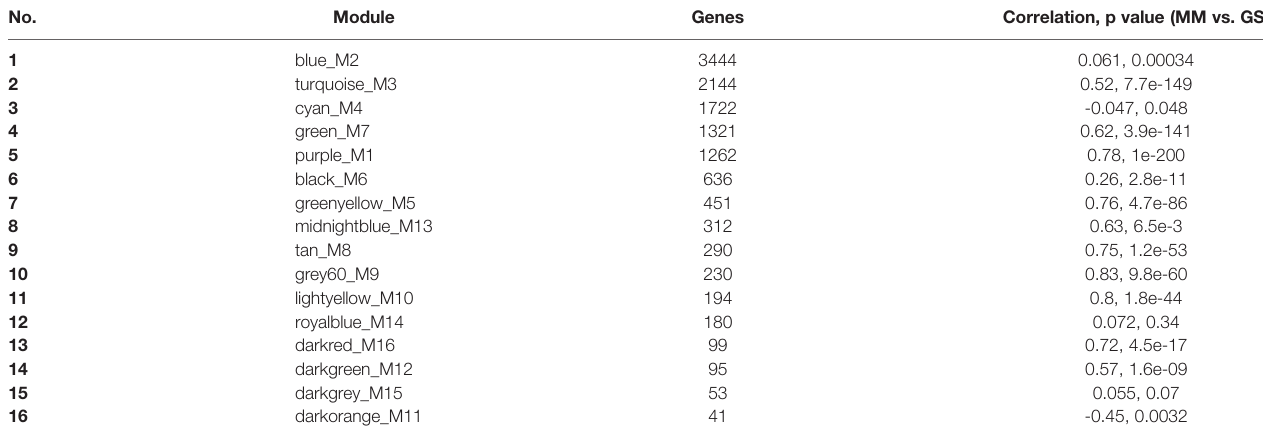
TABLE 1 | The number of mRNAs in the 16 modules. No. Module Genes Correlation, p value (MM vs. GS)